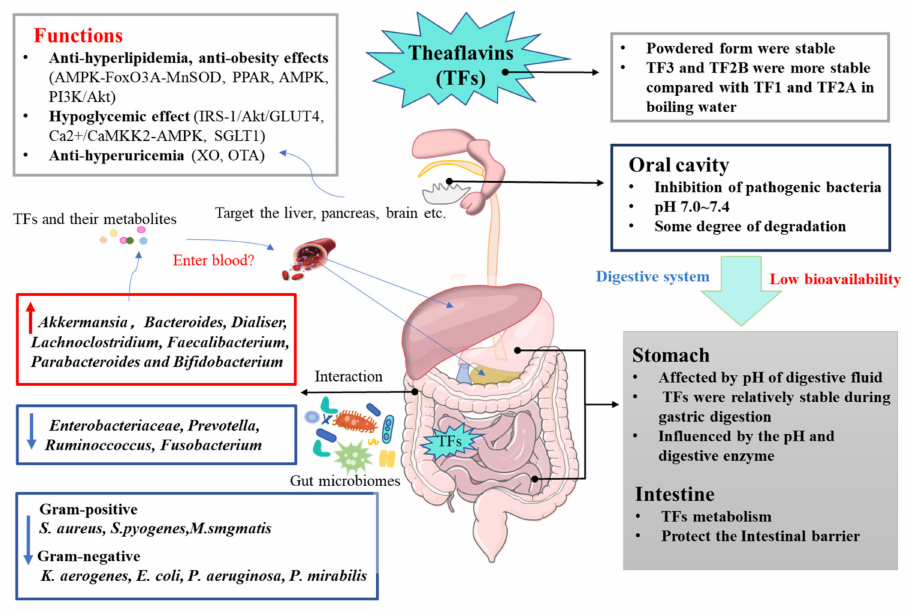
Figure 3. Bioavailability of TFs and mechanism of TFs on metabolic